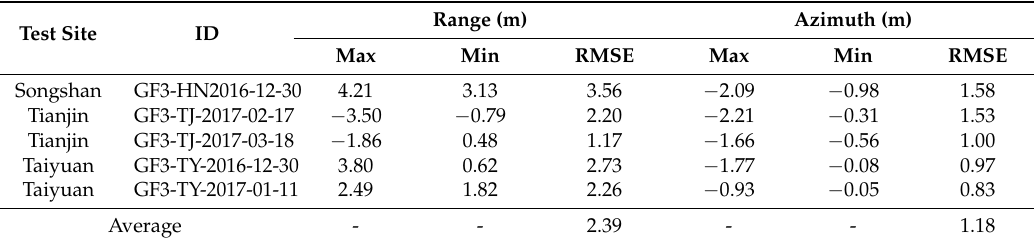
Table 4. Absolute positioning accuracy after cross-calibration. RMSE: root mean square